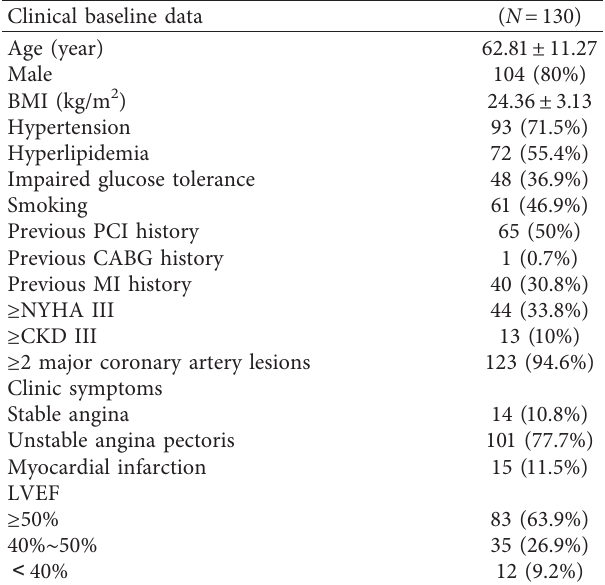
Table 3: Clinical baseline data of the study population. Clinical baseline